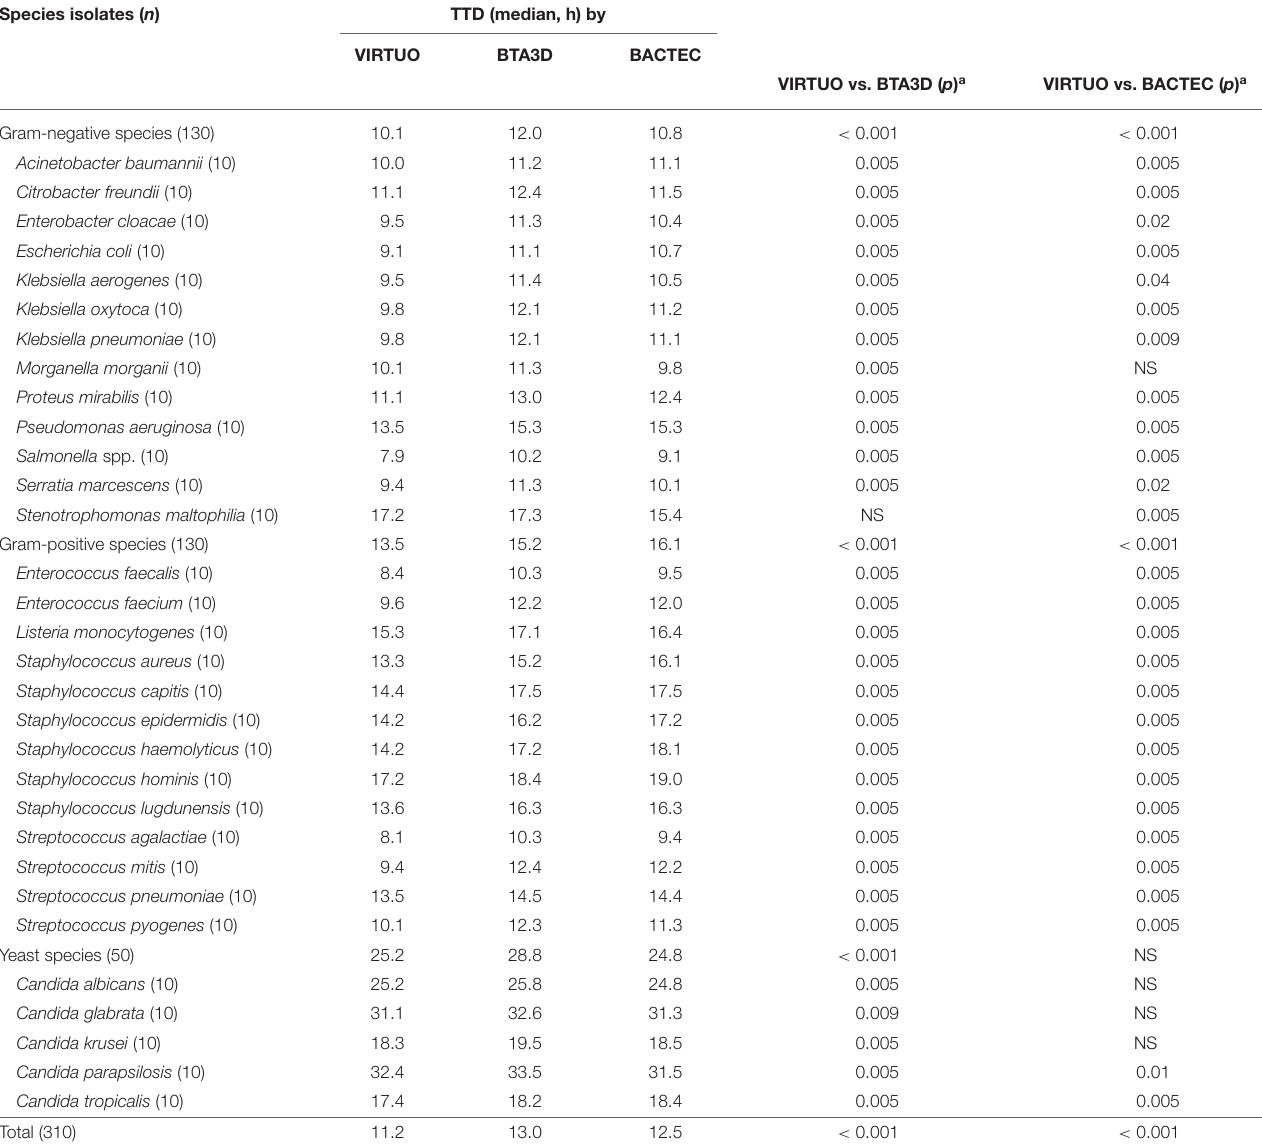
TABLE 2 | Time to detection (TTD) in pediatric blood culture (BC) bottles from the VIRTUO, BTA3D, and BACTEC BC systems. Species isolates ( n